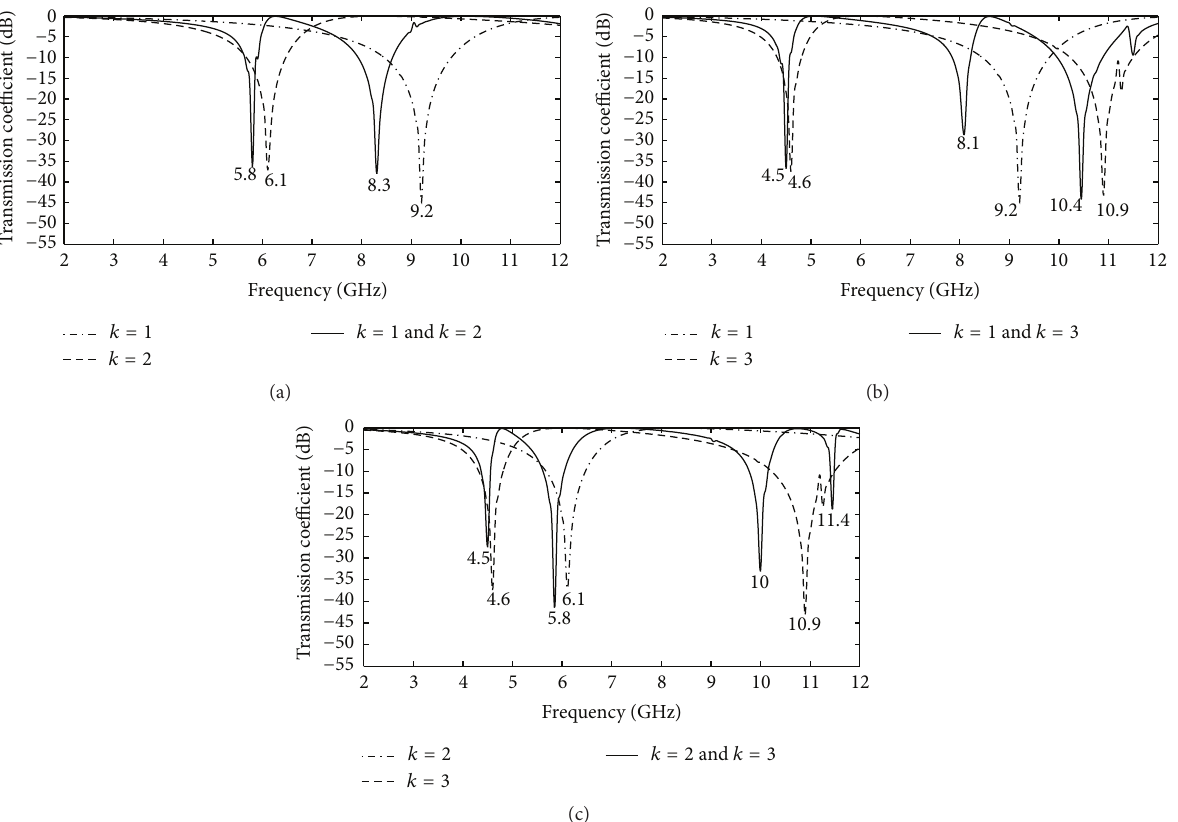
Figure 5: Simulated transmission coefficient results versus frequency obtained for the proposed spatial filters with two dissimilar Sierpinski fractal patch elements and for the FSS geometries with identical fractal level: (a) 𝑘 = 1 , 𝑘 = 2 , and 𝑘 = 1 and 𝑘 = 2 , (b) 𝑘 = 1 , 𝑘 = 3 , and 𝑘 = 1 and 𝑘 = 3 , and (c) 𝑘 = 2 , 𝑘 = 3 , and 𝑘 = 2 and 𝑘 = 3 .